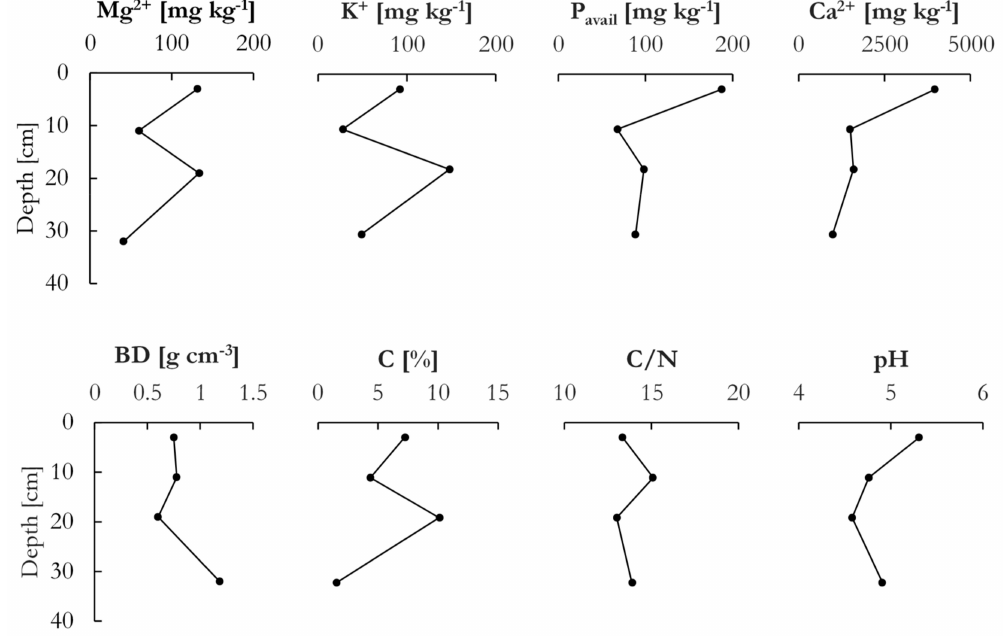
Figure 3. Selected chemical and physical properties of the soil profile. P avail : plant-available P; BD: bulk density.